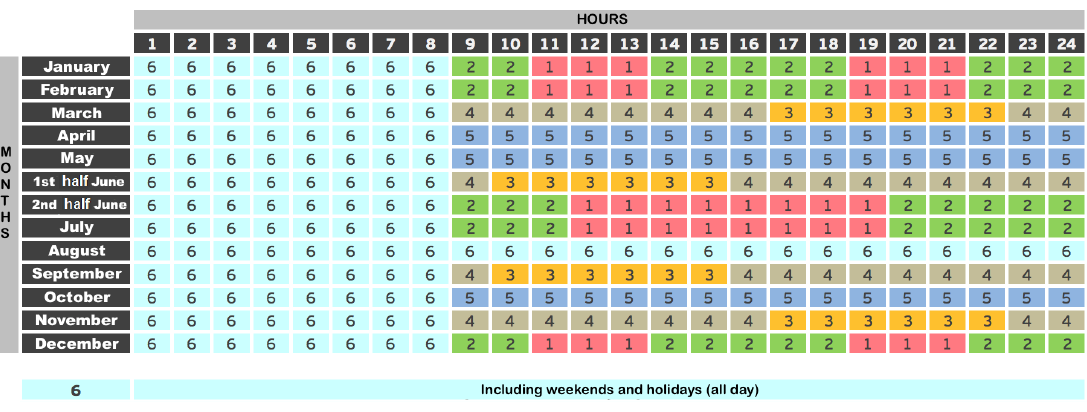
Figure 1. Spanish tariff structure (tariff 6.1. A: six periods for consumers with >1 kV and >450